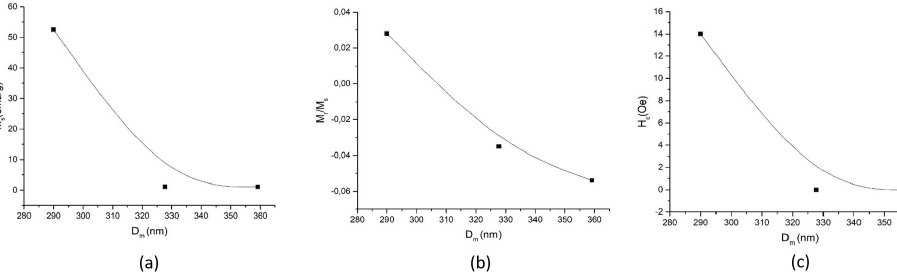
Figure 5. Correlation of the particle size of ZnFe